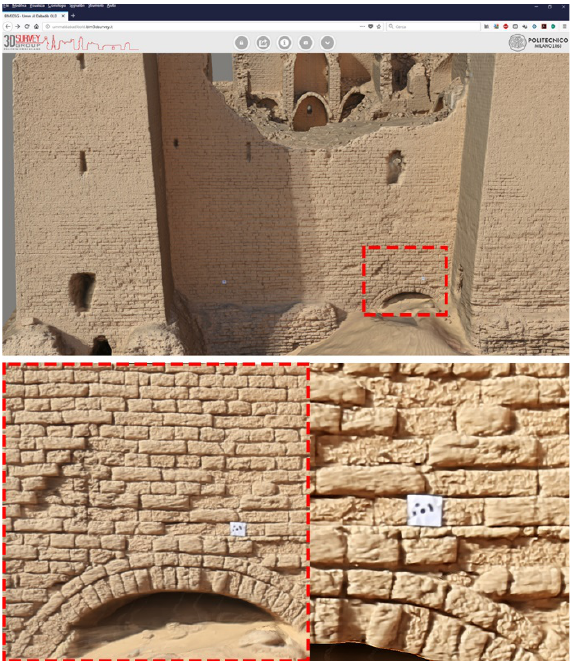
Figure 4: Polygonal model of Umm al-Dabadib Fort on the BIM3DSG system, composed by 25-texture 4.96x4.096 pixel (area mesh 1420 m 2 ,